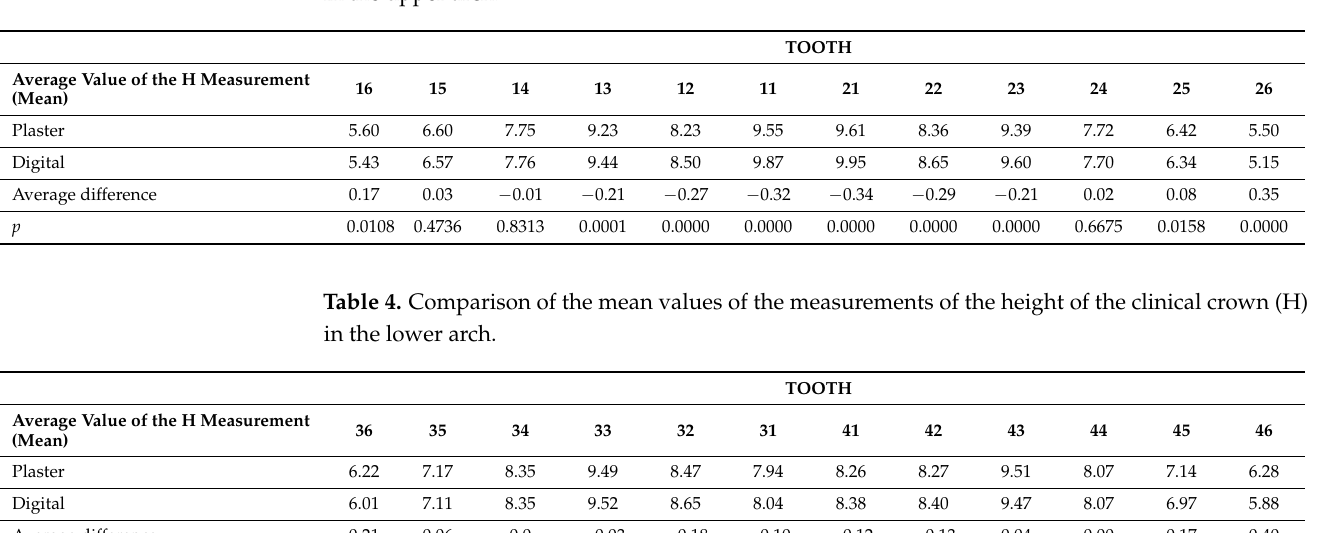
Table 3. Comparison of the mean values of the measurements of the height of the clinical crown (H) in the upper arch.